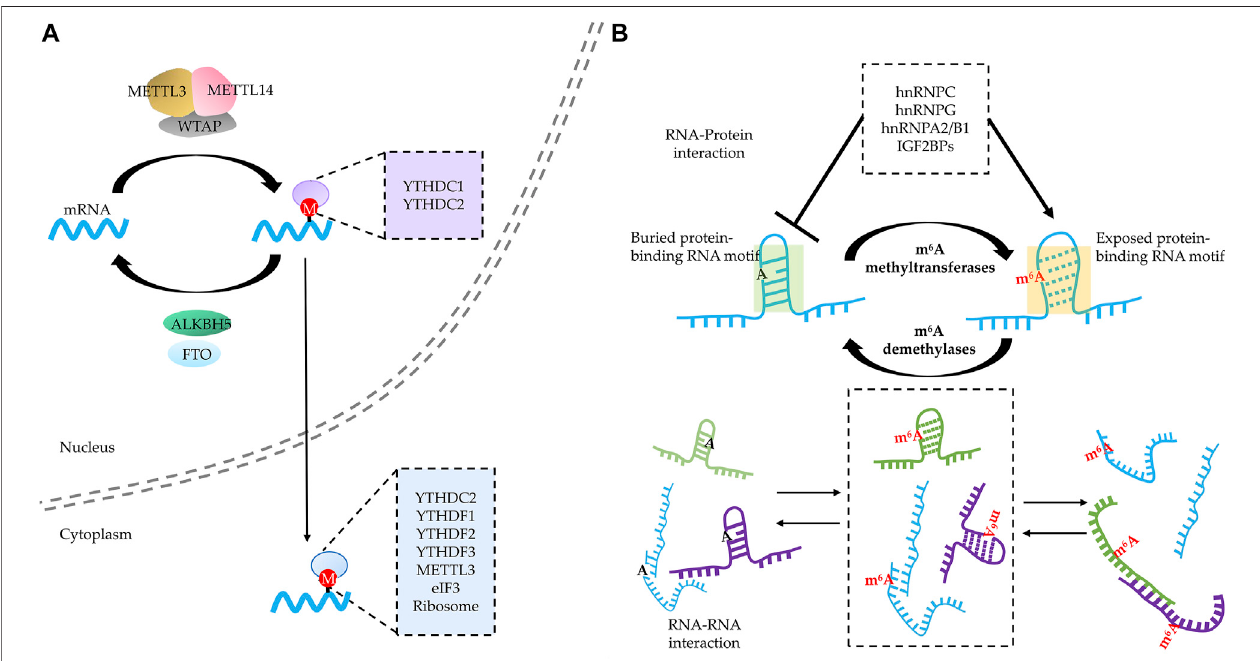
FIGURE2| RNAN 6 -methyladenosine(m 6 A)modi fi cationregulatesRNA – RNAandRNA – proteininteractionsofmodi fi edRNA. (A) RNAm 6 Amodi fi cationactsasa “ beacon ” to directly recruit various m 6 A readers in both the nucleus and cytoplasm. (B) RNA m 6 A modi fi cation modulates RNA – RNA and RNA – protein interaction through “ structural switcher ” function. m 6 A modi fi cation promotes the instability of RNA base complementary pairing and thus leads to deconstruction of the corresponding structure, reshaping the spectrum of RNA – protein and RNA – RNA interaction.